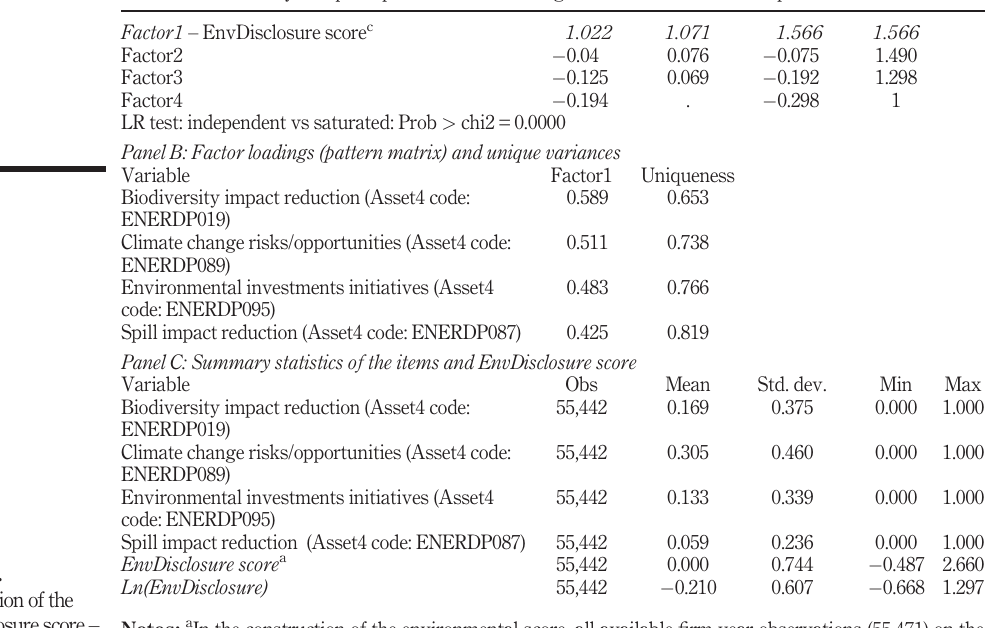
Table 1. Construction of the EnvDisclosure score – factor